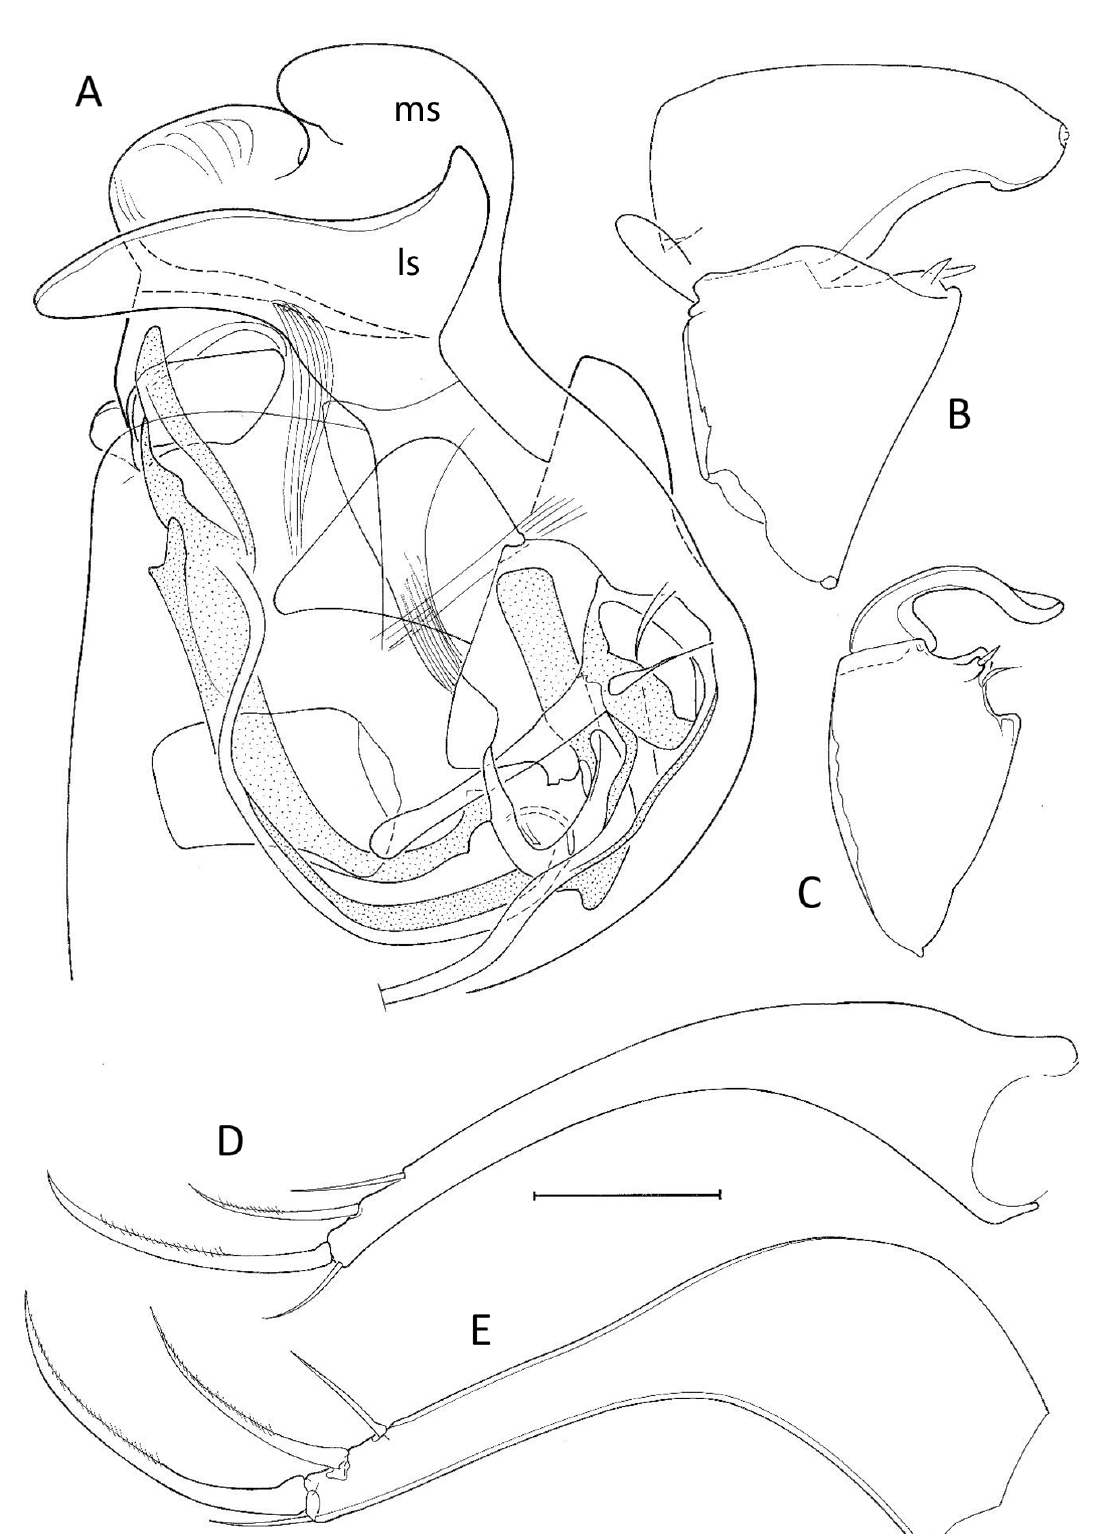
Fig. 5. Patcypris outback gen. et sp. nov. A–C . ♂, holotype (WAM 67184) from Lake Maitland (type locality, sample LN5217). A. Hp. B. Rpp. C. Lpp. D . CR, ♂ (WAM 67197) from Lake Carey (sample OSTR60C). E . CR, ♀ (WAM 67198) from Lake Carey (sample OSTR60C). Scale = 92